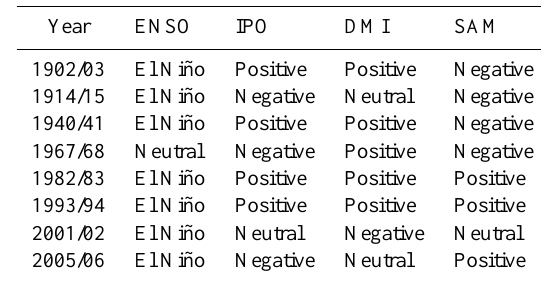
Table 1. Climate drivers during years when dry events coincide across the Southern